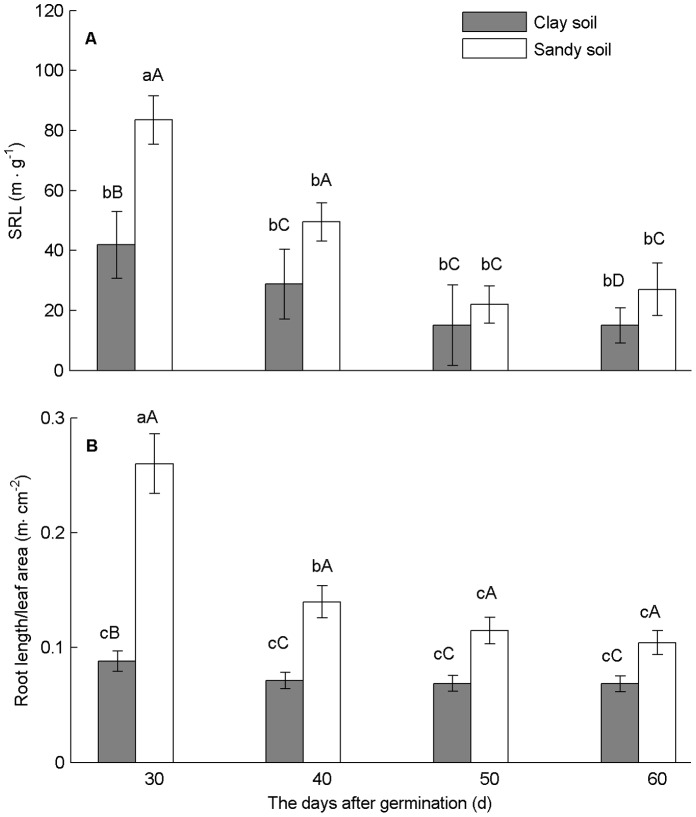
Specific root length and root/leaf ratio in the two soil textures at four growth stages.(A) SRL; (B) root length/leaf area ratio. Bars represent average values ± SE, n = 15. Different lower-case and capital letters indicate differences (p≤0.05) between growth stages and between soil textures, respectively.